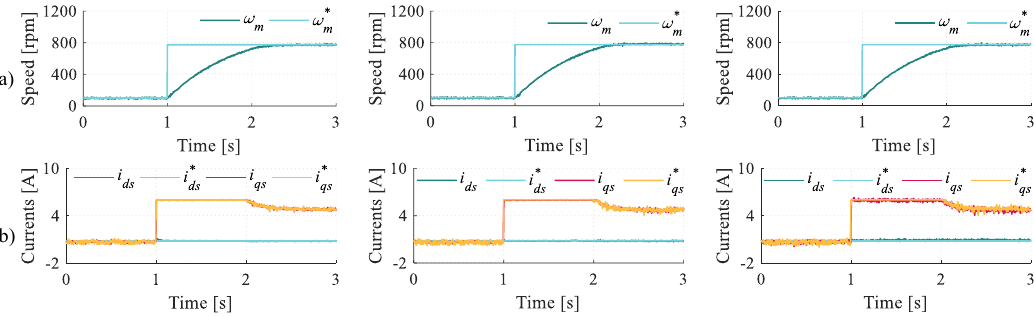
Figure 11. Test 3A. Speed-step response for a V dc = 300 V for IRFOC CB-PWM ( left ), IRFOC SV-PWM ( center ) and LFCS-MPC ( right ). From top to bottom: ( a ) Mechanical speed and ( b ) d − q currents.